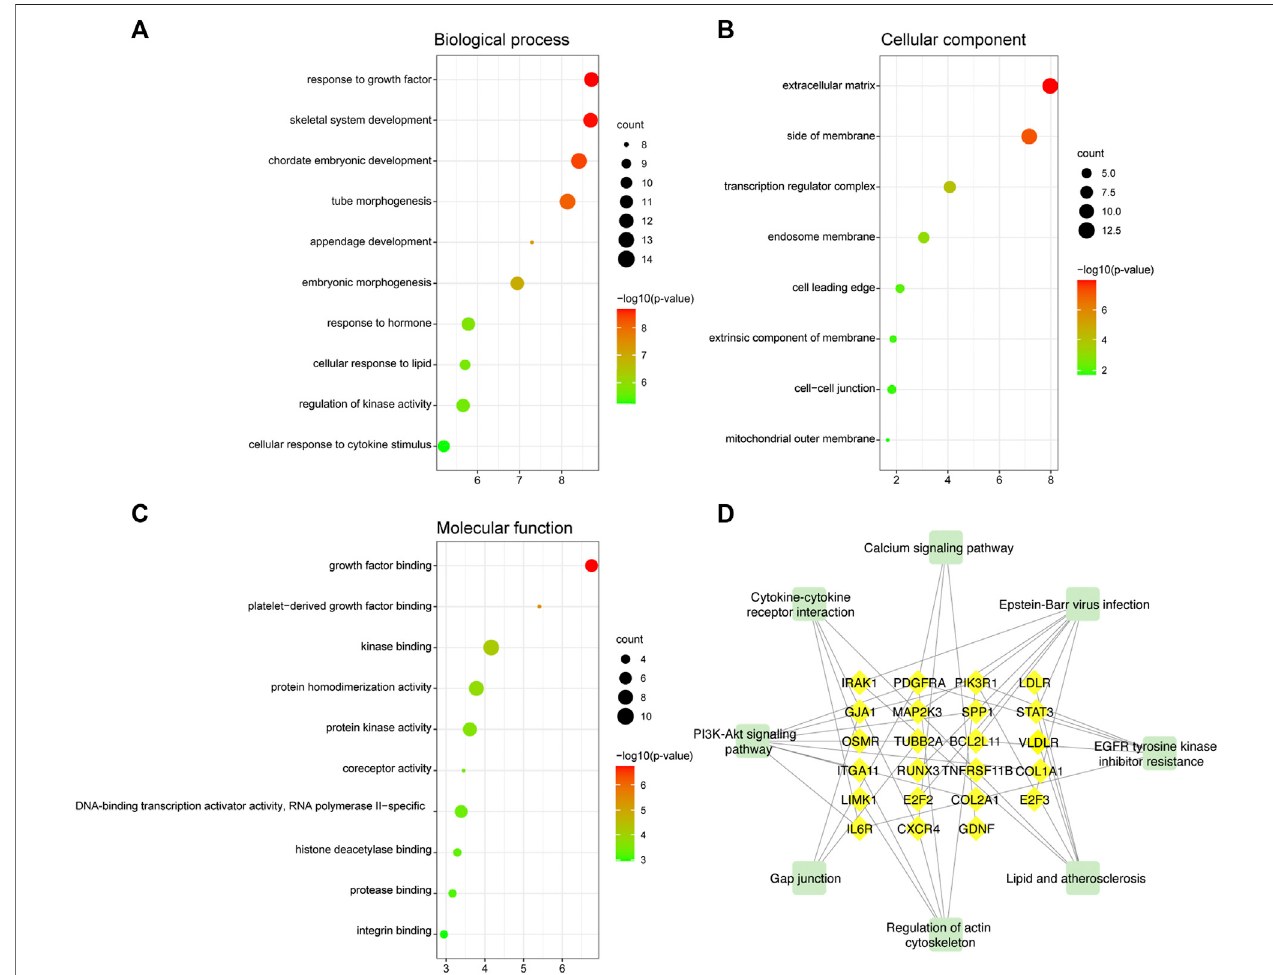
FIGURE 7 | GO and KEGG functional enrichment analyses of mRNAs in the ceRNA regulatory network. (A) Biological process analysis. (B) Cellular component analysis. (C) Molecular functionanalysis.Thecolorintensityofthenodes showshow richtheanalysisis. Theenrichmentfactor isde fi ned astheratioofdifferential genes inthewholegenome.Thesizeofdotrepresentsthenumberofgenesinthepathway. (D) KEGGpathwayanalysis.Thegreenrectanglerepresentedthepathwayandthe yellow diamonds represented mRNA.